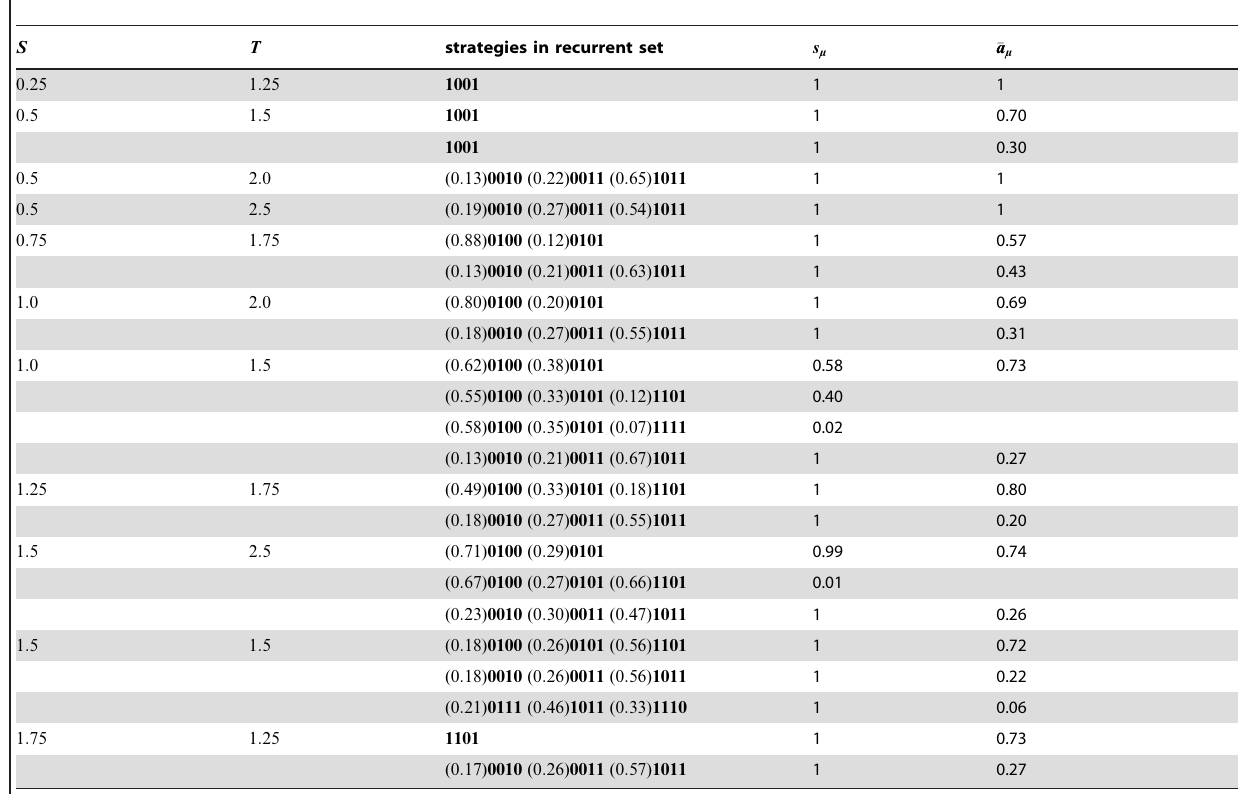
Table 1. Recurrent sets found in the Snowdrift game